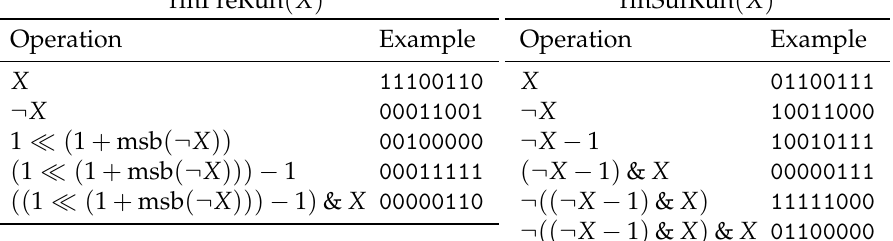
Figure 3. Step-by-step execution of rmPreRun ( X ) and rmSufRun ( X ) introduced in Figure 2 on a bit vector X .